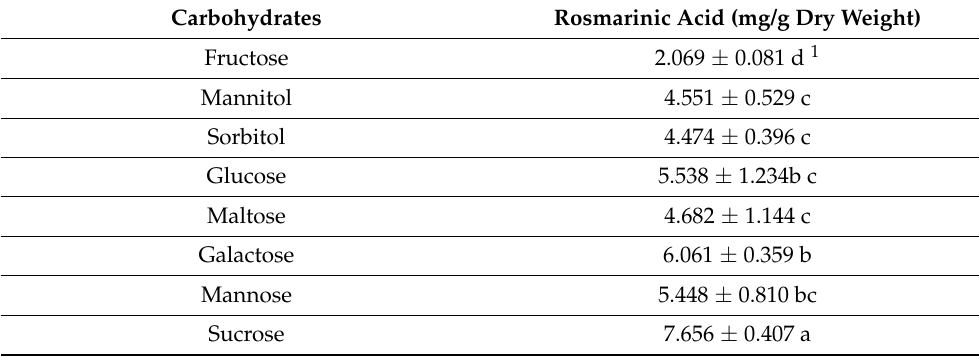
Table 2. Effects of different carbohydrates on the accumulation of rosmarinic acid in hairy root cultures of A. rugosa .